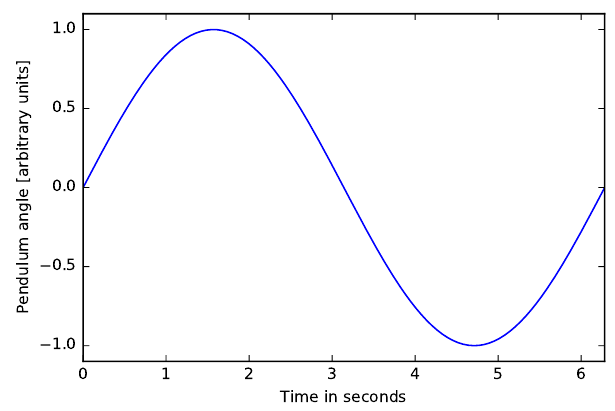
Fig. 83.— Sine curve with custom range and proper axis names We can make a bewildering number of additional changes. (Of course, it is a sign of plotting maturity when those options are used sparingly, and only when they are in the service of helping the figure’s readibility.) line width, and line style for our